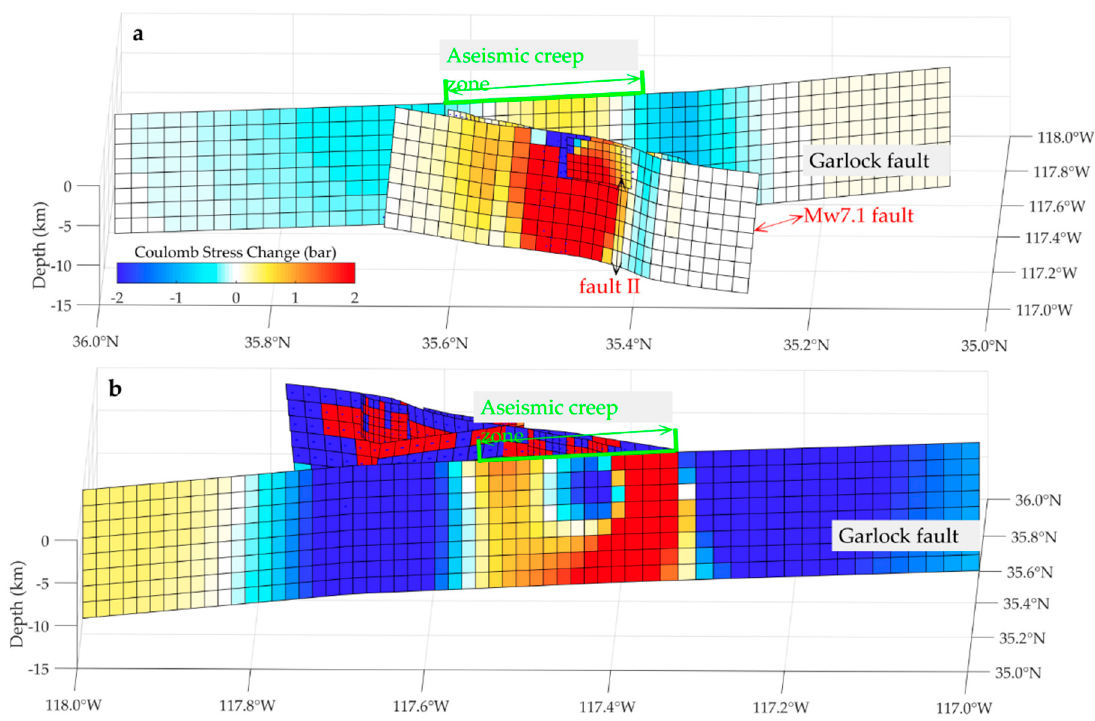
Figure 12. Static Coulomb stress changes (CSC) on multiple faults due to the 2019 earthquakes. ( a ) CSC on the Mw7.1 faults and the Garlock fault plane caused by the Mw6.4 event; ( b ) CSC on the Garlock fault plane caused by the 2019 Ridgecrest earthquake sequence. The green line indicates the aseismic creep triggered by these earthquakes. Static coefficient of friction is 0.2. Positive stress change is consistent with unclamping of the faults, and a negative stress change leads to clamping of the faults.